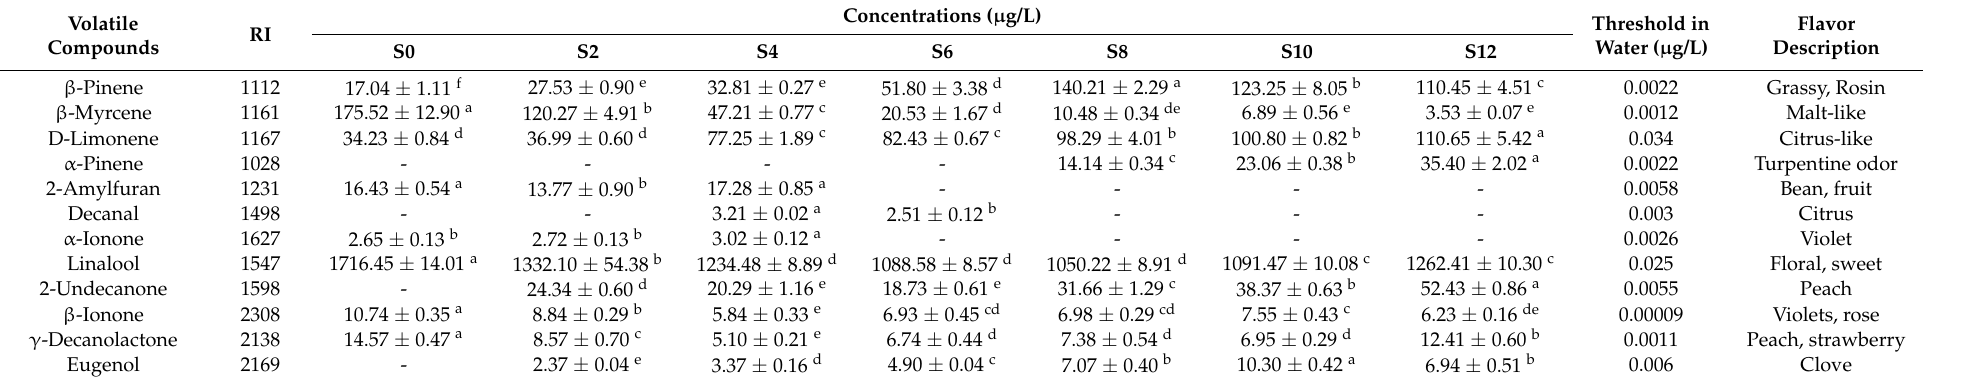
Table 1. OAVs and flavor descriptions of selected main volatile compounds in seven fermentation stages of apricot